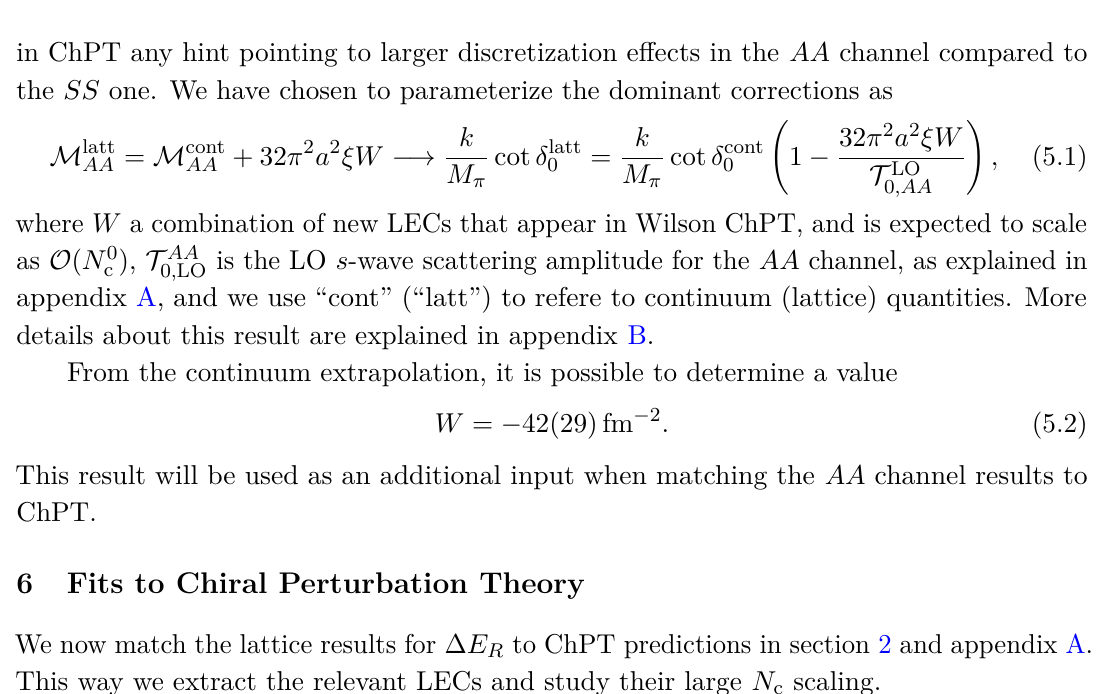
Figure 8 . Results for the s -wave phase shift of the AA channel for two regularizations, as indicated in the figure legend. We graphically show how one of the points — corresponding to the 3A40 ensemble — is extrapolated to k 2 = − 0 . 08 M 2 , using the ERE and a prior for the effective range π ref based on ChPT, M 2 a AA r AA ∈ [ − 5 , − 1] , as explained in the main text. Dotted lines illustrate the π 0 0 error introduced by the width of this